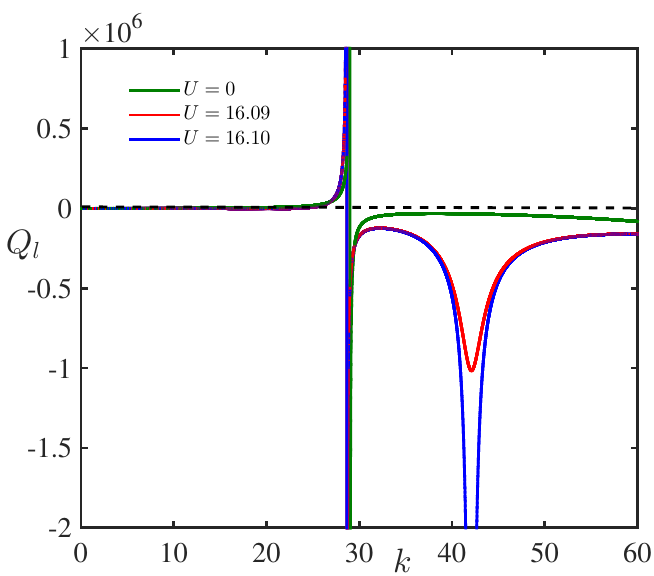
Figure 9. (Color online) Variation of the nonlinear coefficient Q l versus wavenumber k for different values of wind speed U in the case of lower branch of dispersion curve.